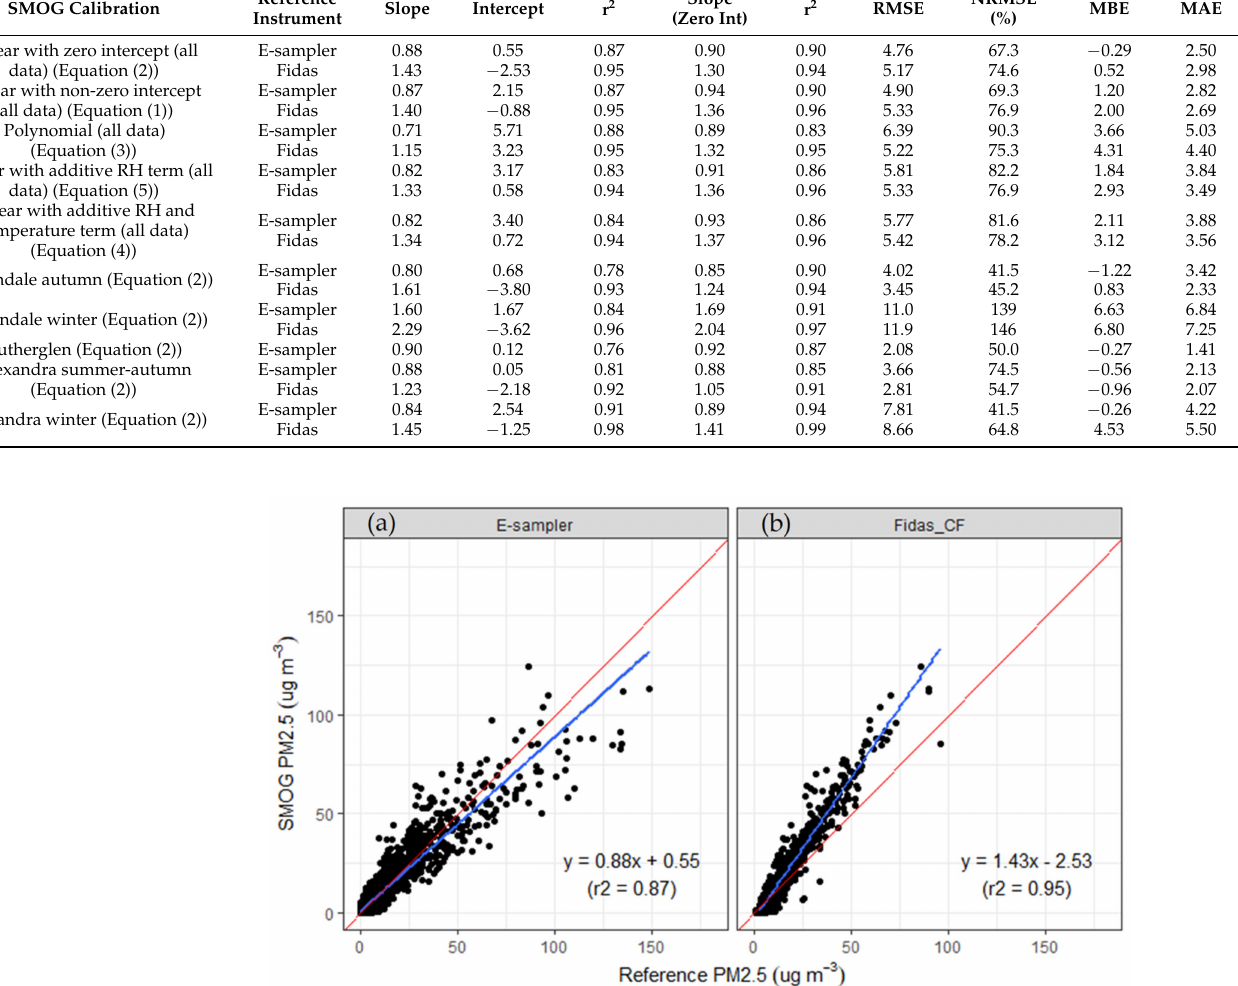
Figure 3. Scatterplot of hourly PM 2.5 concentrations measured with the SMOG units compared to ( a ) the E-sampler and ( b ) Fidas_CF (both of which have been corrected against gravimetric mass measurements). Blue lines show linear least-squares fit; red line represents 1:1